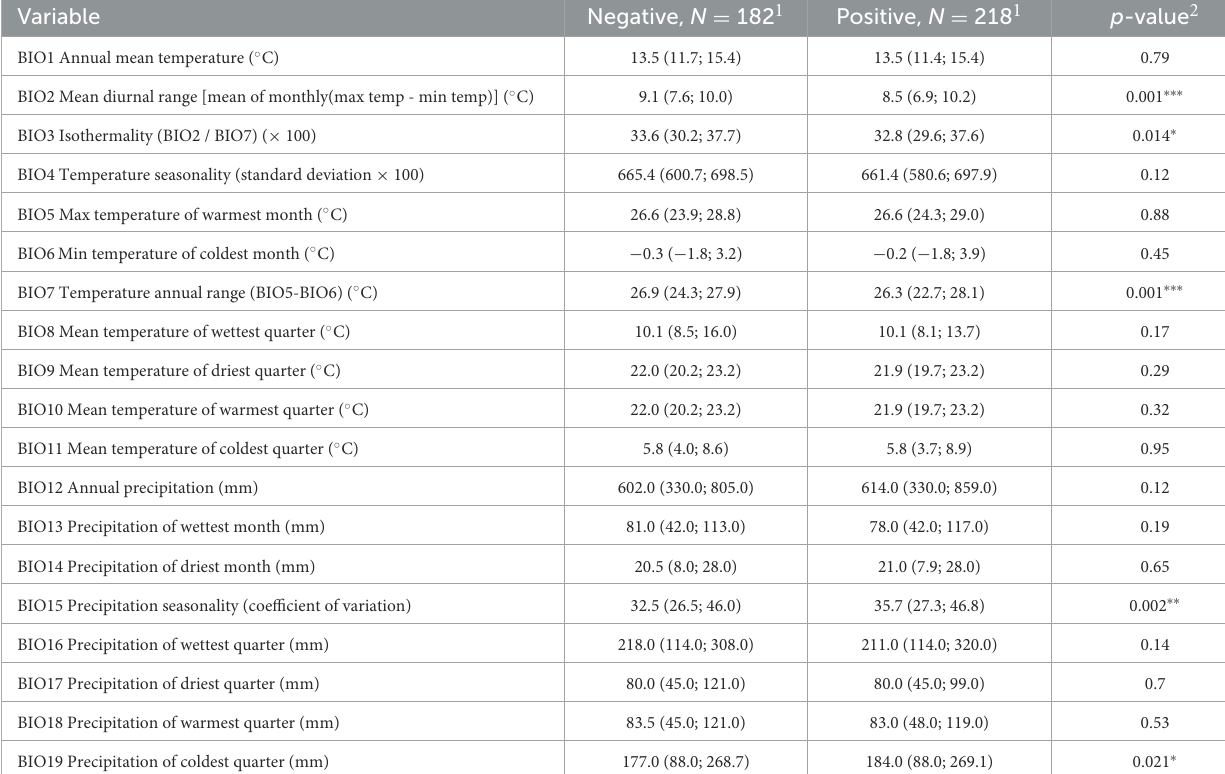
TABLE 1 Taxoplasma gondii seropositive rate by bioclimatic